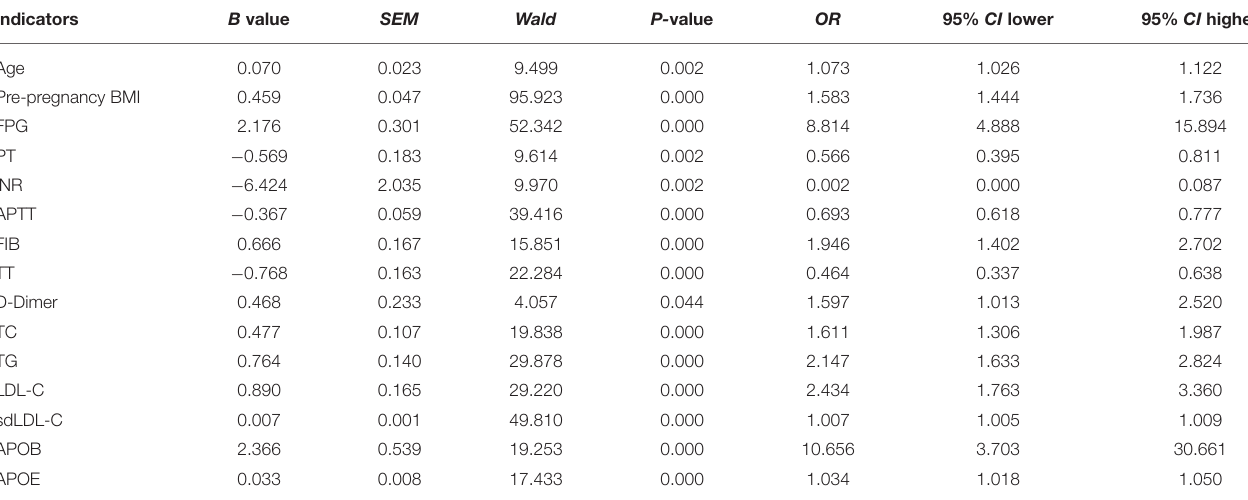
TABLE 3 | Univariate logistic regression analysis results of predictors of GDM.